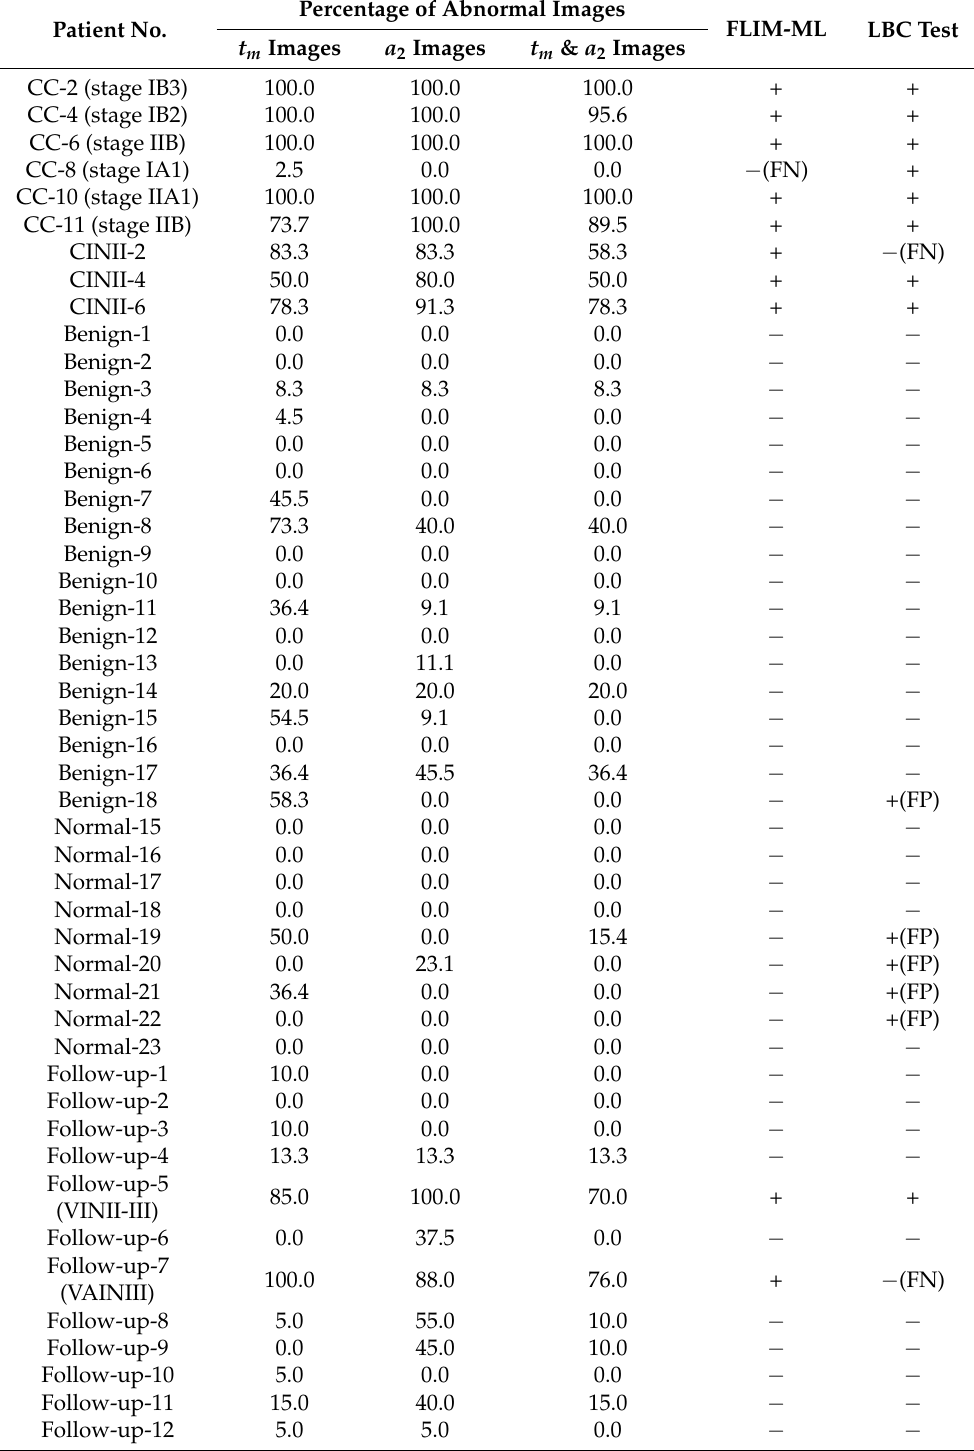
Table 3. Percentage of abnormal images in the validation group and the results of FLIM combined with machine learning. For comparison, the results of the LBC test of the patients are also listed. Patient